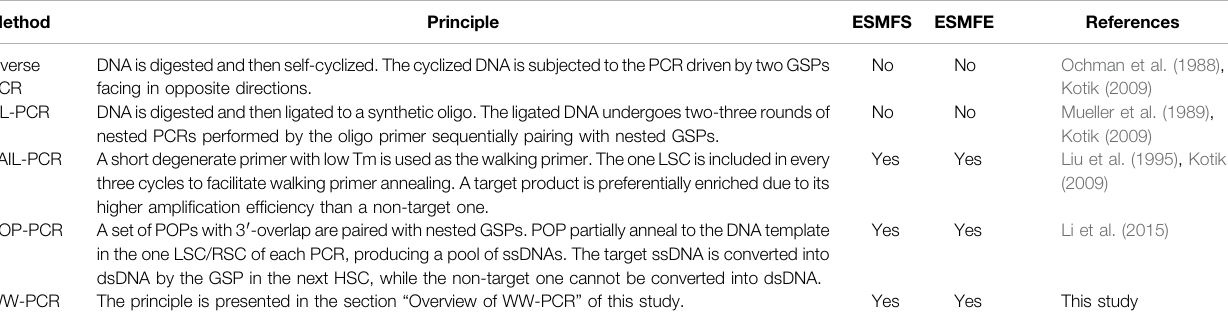
TABLE 4 | Comparison of different PCR-based genome walking